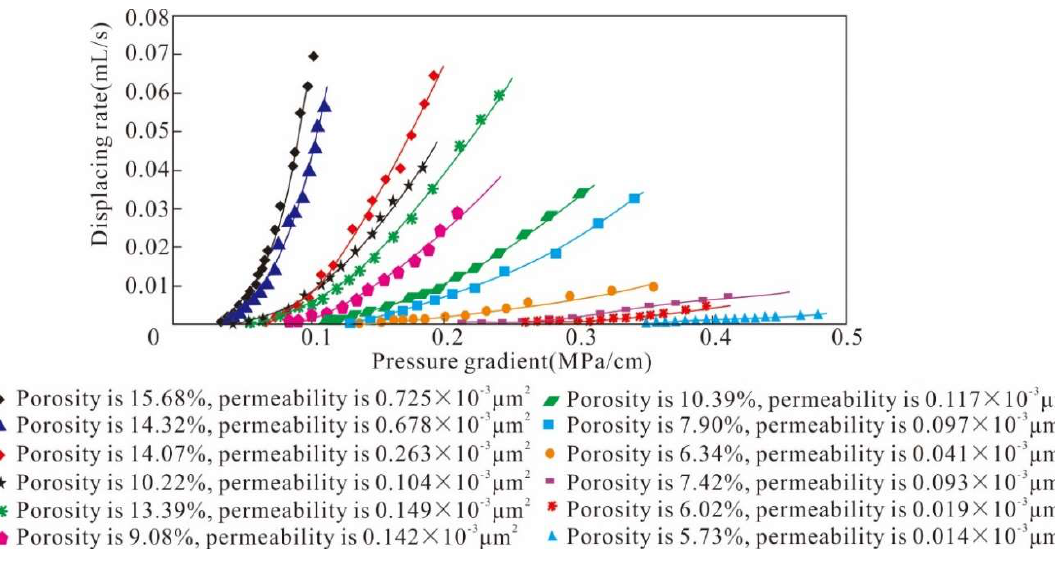
Figure 8. The gas migration flow curve of low-permeability sandstone in Sulige gas field.